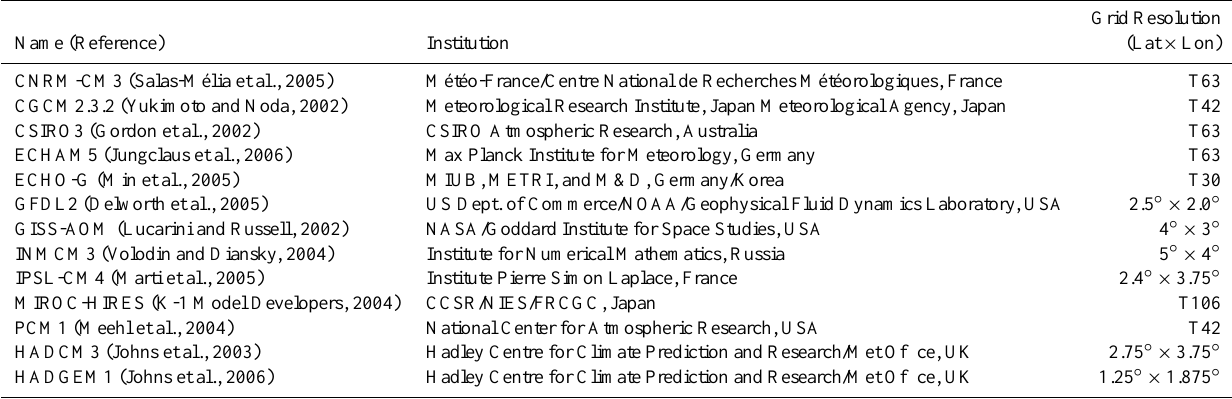
Table 1. List of GCMs used in the study. These constitute the subset of all GCMs included in the PCMID/CMIP3 project providing all the climate variables of our